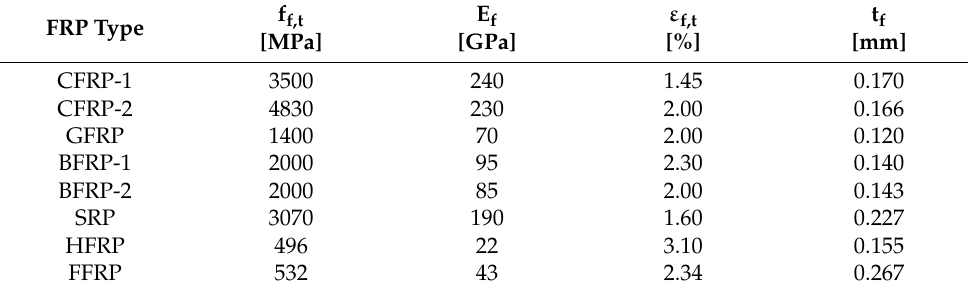
Table 2. Properties of FRP